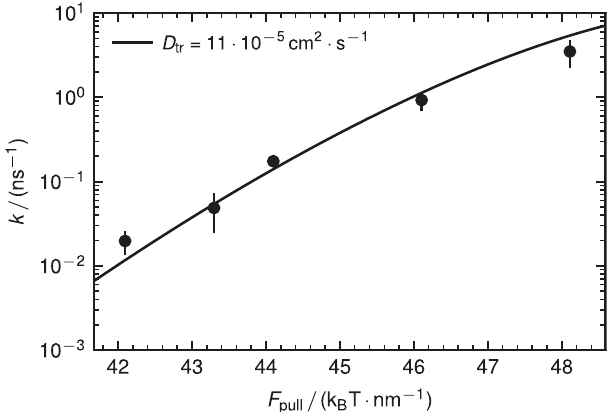
Fig. 5 Ion-evaporation rate. Evaporation rate k of a chloride ion from protocol (IV) simulations as a function of the applied force F pull , error bars denote the standard deviation of independent simulations runs divided by the square root of their number. The solid line shows the Kramers rate Eq. (7) in the limit L → 0 with a fi tted transition-state diffusion constant D ¼ 11 (cid:5) 10 (cid:2) 5 cm 2 (cid:5) s (cid:2) 1 tr